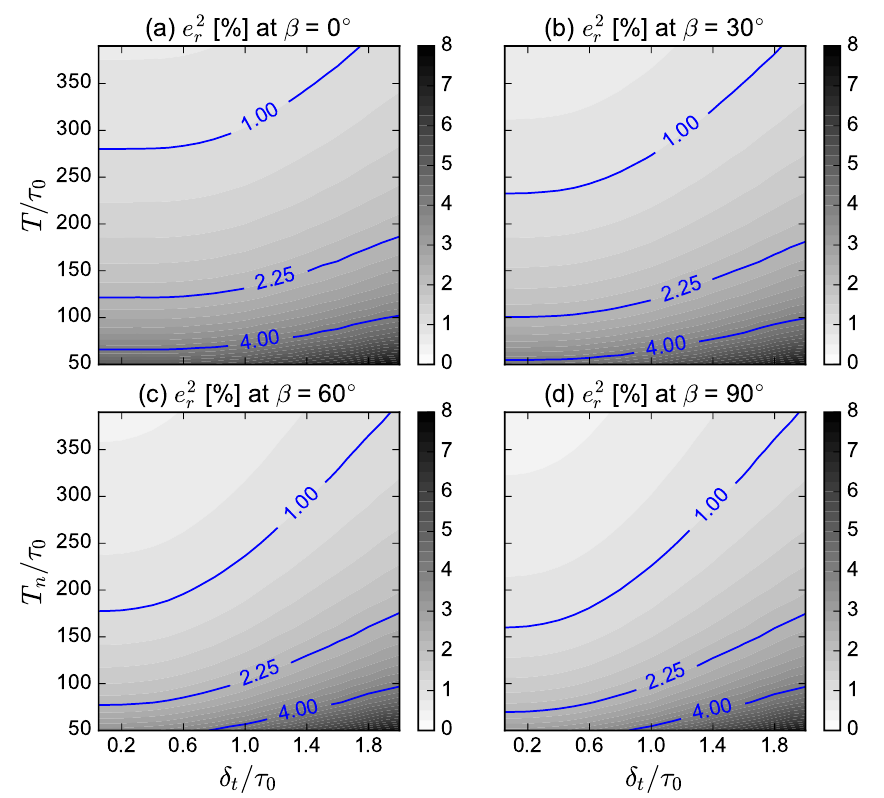
(cid:16) (cid:17) e 2 r Figure 12. Contours of the relative variance of random errors of radial velocity variance from lidar measurements estimated with the isotropic turbulence model (Pope, 2000) and the von Kármán spectra (Burton et al., 2011) as a function of the sampling duration ( T ) and the sampling interval ( δt ) normalized by the integral timescale ( τ 0 ) for four different β values, where β is the angle between the LOS and the wind direction. The weighting function (Eq. 5) representing the volumetric averaging has a standard deviation σ Q = 0 . 2 L 1 , where L 1 is the streamwise integral length scale. The other input parameters include the elevation angle φ = 10 ◦ and the mean wind speed U 1 = 8ms − 1 .